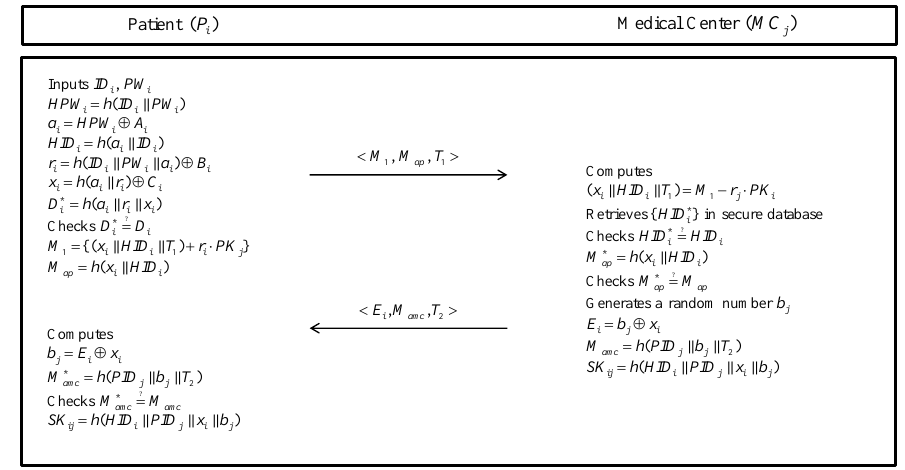
Figure 4. Authentication phase of the proposed